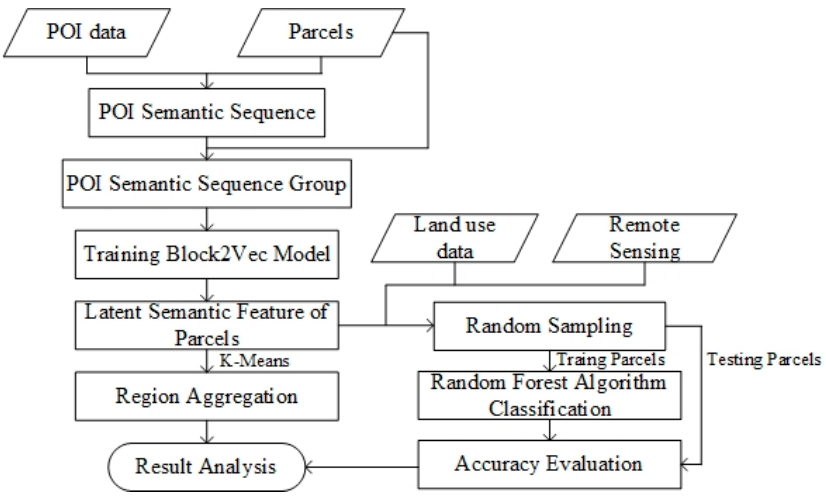
Figure 2. The workflow of the urban functional region classification.